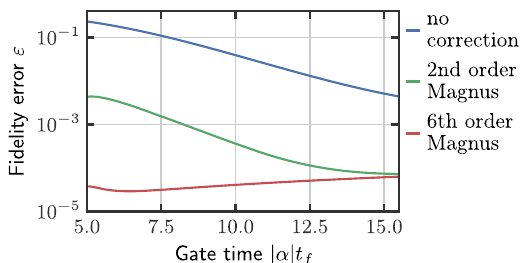
Fig. 5 In fl uence of decoherence on corrected single-qubit gates with a transmon. Average fi delity error for a Hadamard gate as a function of gate time in the presence of decoherence. Here, we used the experimental values found in ref. 63 for the relaxation time, T 1 = 49 μ s, and dephasing time, T φ = 700 μ s. The qubit frequency is ω q / 2 π = 5.5 GHz and α = − 0.05 ω q . The blue trace is calculated using the uncorrected Hamiltonian (see Eq. (69)). The green trace is obtained for the 2nd order corrected Hamiltonian. The red trace is obtained for the 6th order corrected